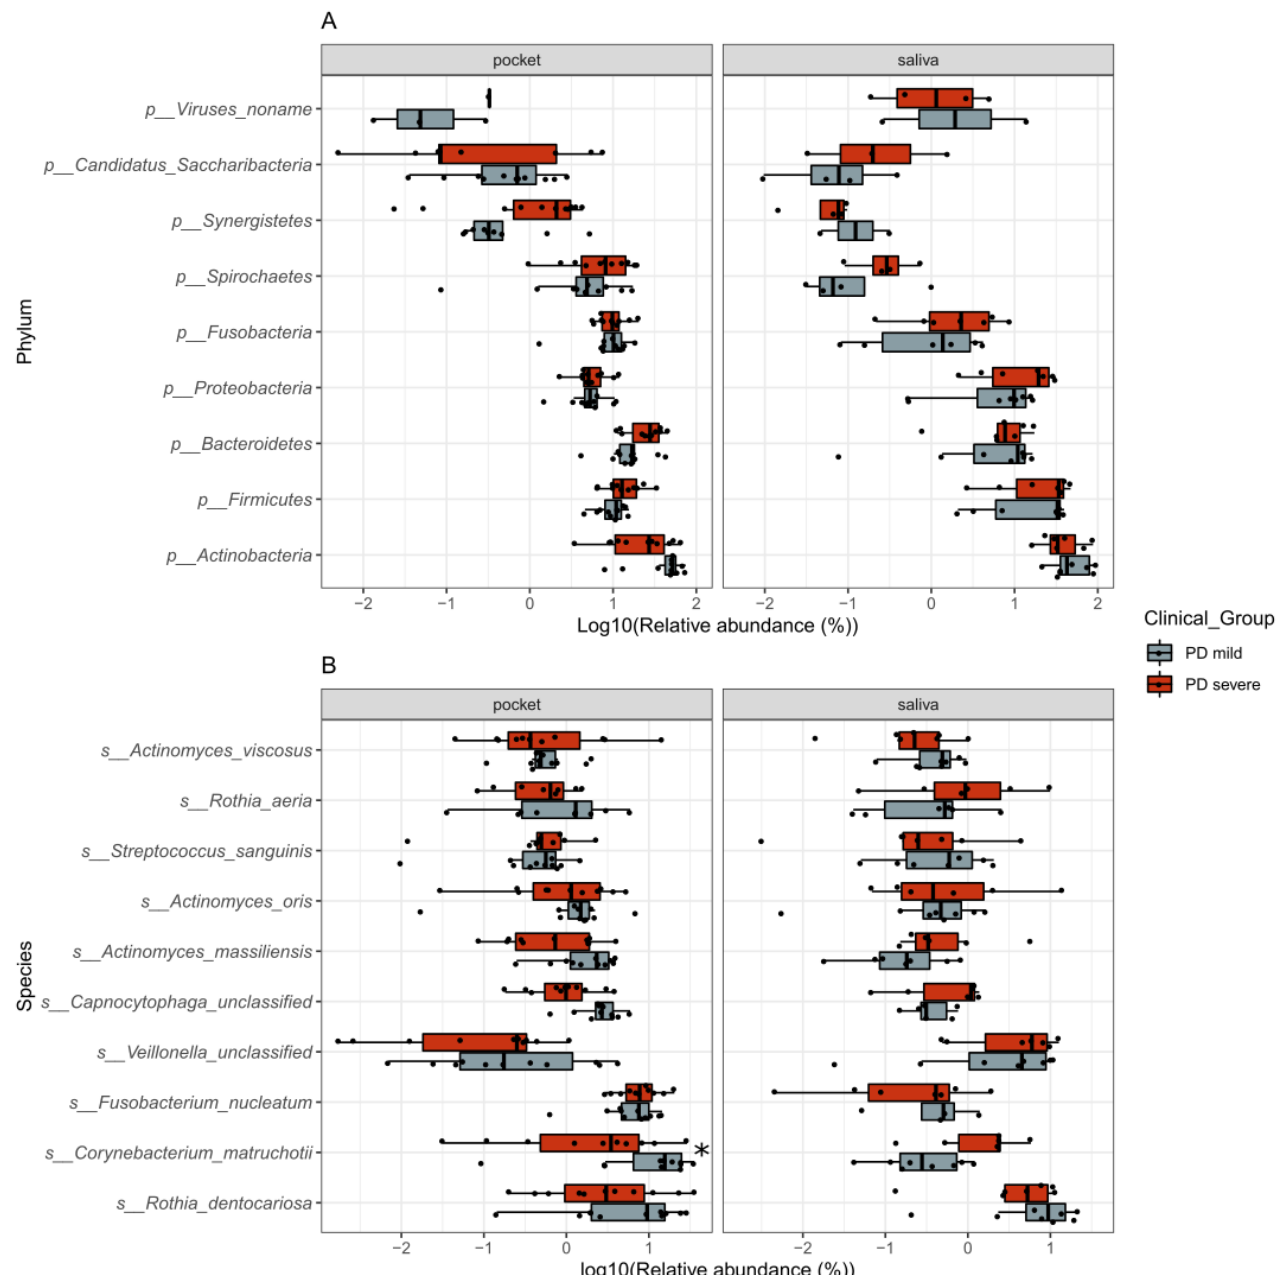
Figure 1. Taxa composition of pocket and saliva samples in each clinical group at the top 10 phylum ( A ) and species ( B ), in pocket ( n = 22, 11 mild PD cases and 11 severe PD cases) and saliva ( n = 15, 8 mild and 7 severe PD cases). Each dot represents the log10 of the relative abundance of taxa in a sample. The distribution of the abundances per clinical group is shown as a Tukey’s boxplot. Samples where the taxa are absent are not shown in the distribution. Significant differences are marked with an asterisk*.